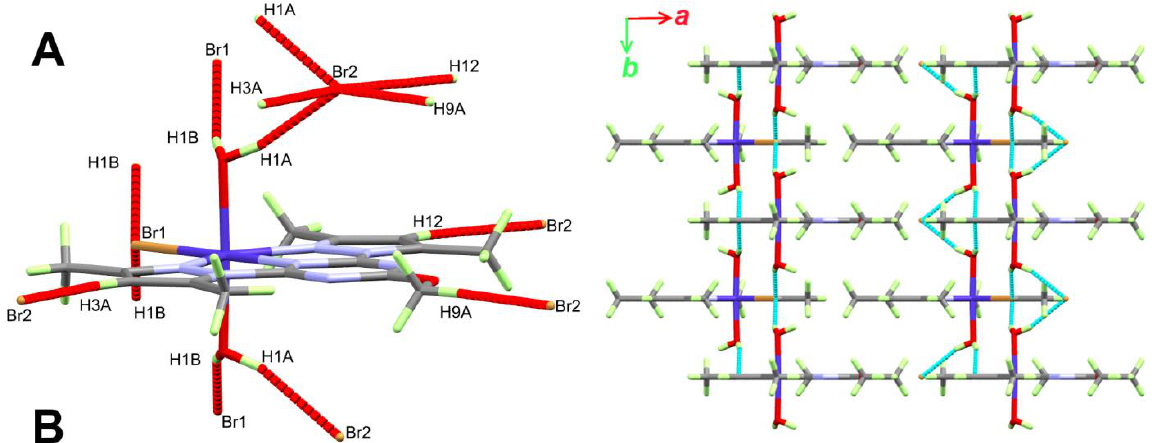
Figure 3. Important contacts ( A ) and packing scheme ( B ) of the [Co(L)(H 2 O) 2 Br]Br complex via O–H…Br hydrogen bonds along the ab plane. All weak C–H…Br interactions were omitted from O–H...Br hydrogen bonds along the ab plane. All weak C–H...Br interactions were omitted from the the packing scheme for better clarity. packing scheme for better